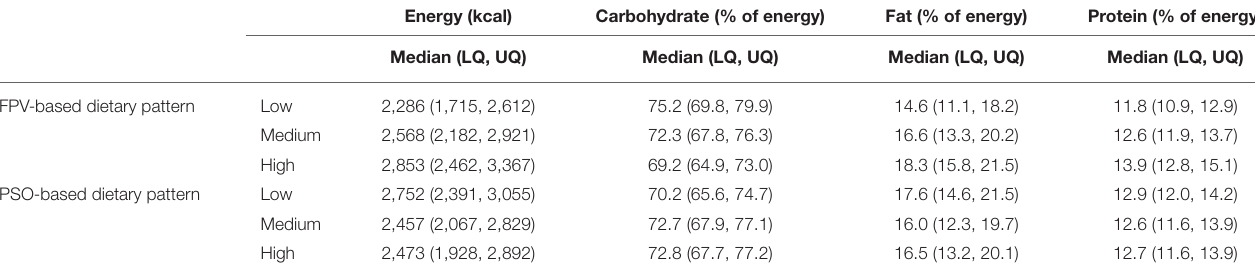
TABLE 3 | Energy and macronutrient consumption of participants according to tertiles of dietary pattern scores. Energy (kcal) Carbohydrate (% of energy) Fat (% of energy) Protein (% of energy) Median (LQ, UQ) Median (LQ, UQ) FPV-based dietary